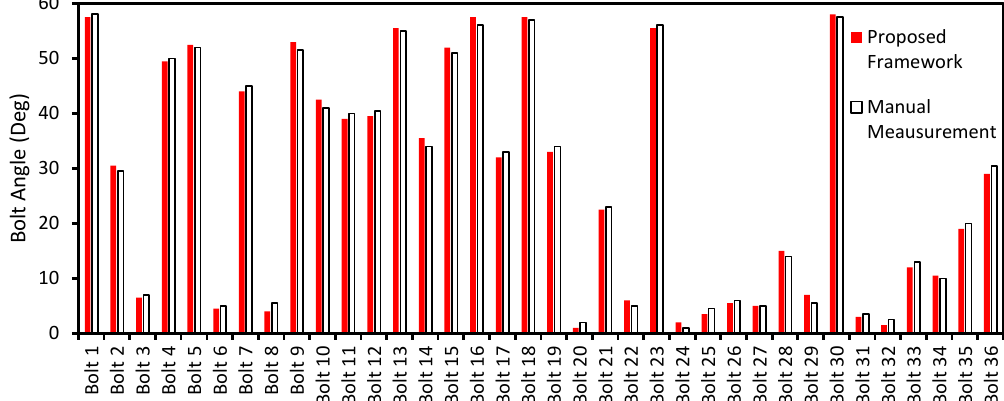
Figure 15. The accuracy of the bolt angle estimation of the inclined bolted connection.